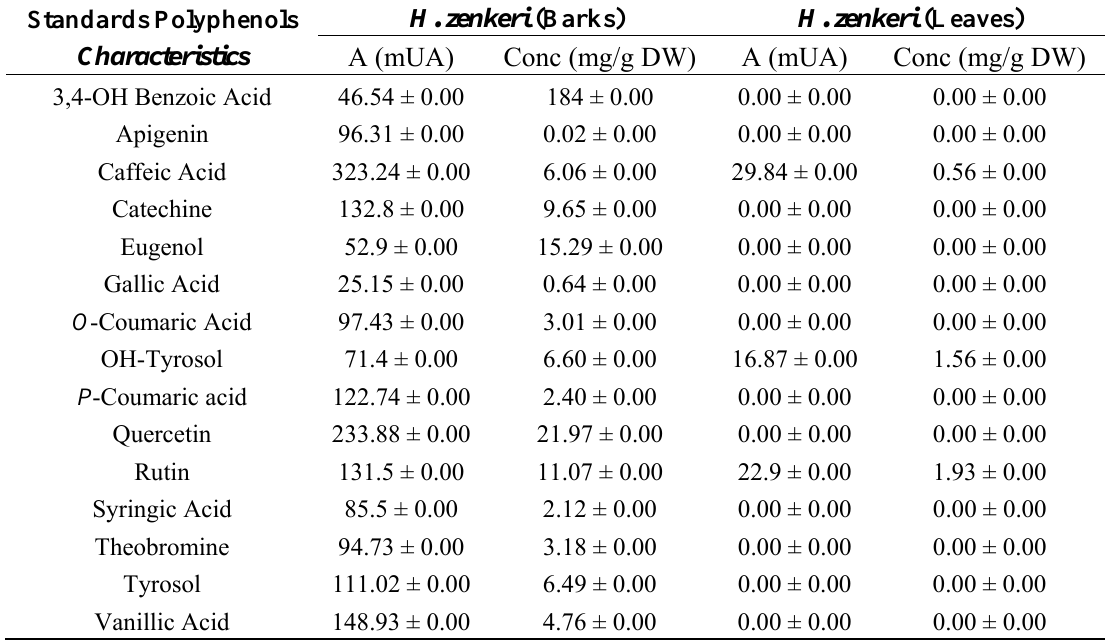
Table 2. Level of phenolic compounds in the different plant